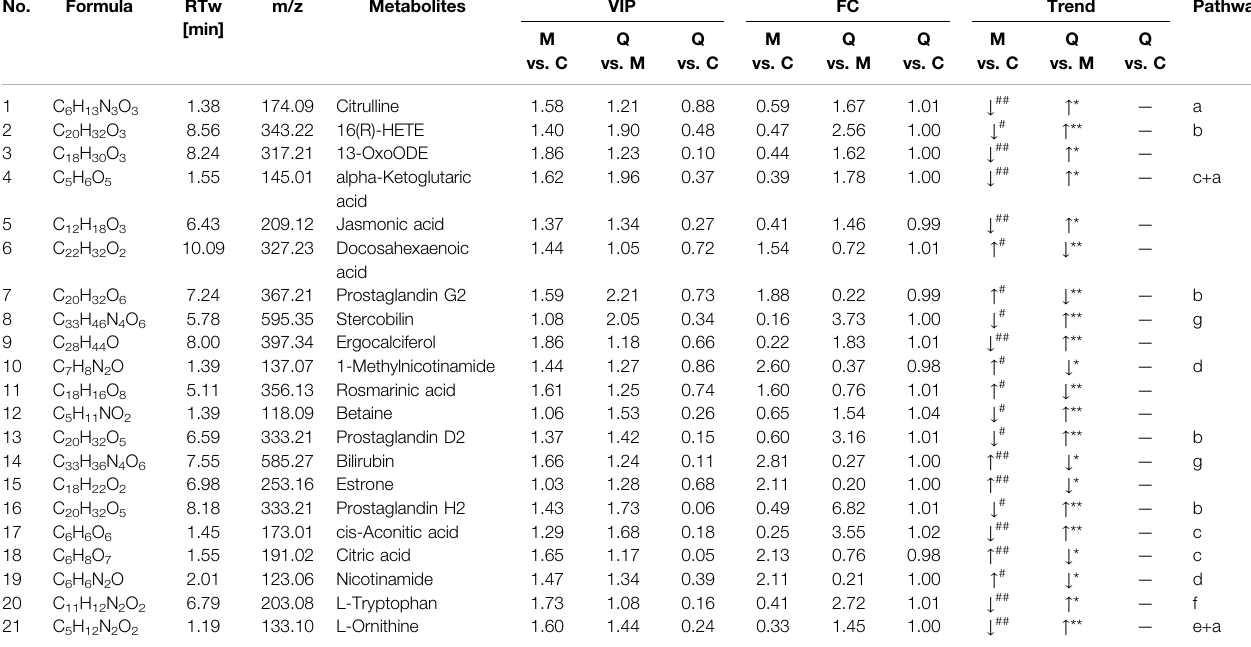
m/z Metabolites VIP FC Trend Pathway [min]